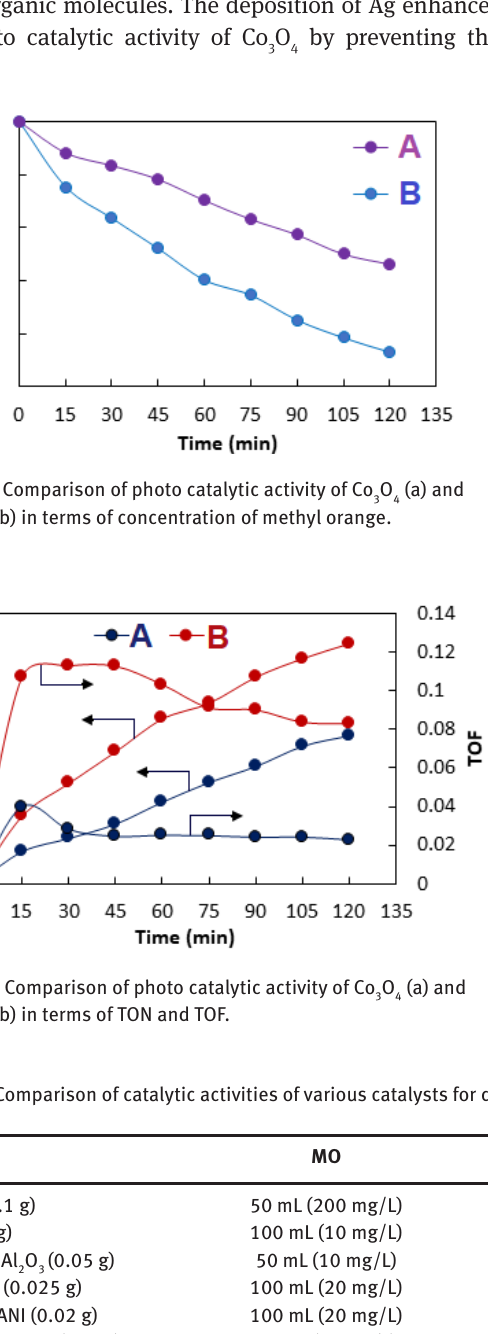
Table 1: Comparison of catalytic activities of various catalysts for degradation of methyl orange (MO) in aqueous medium.